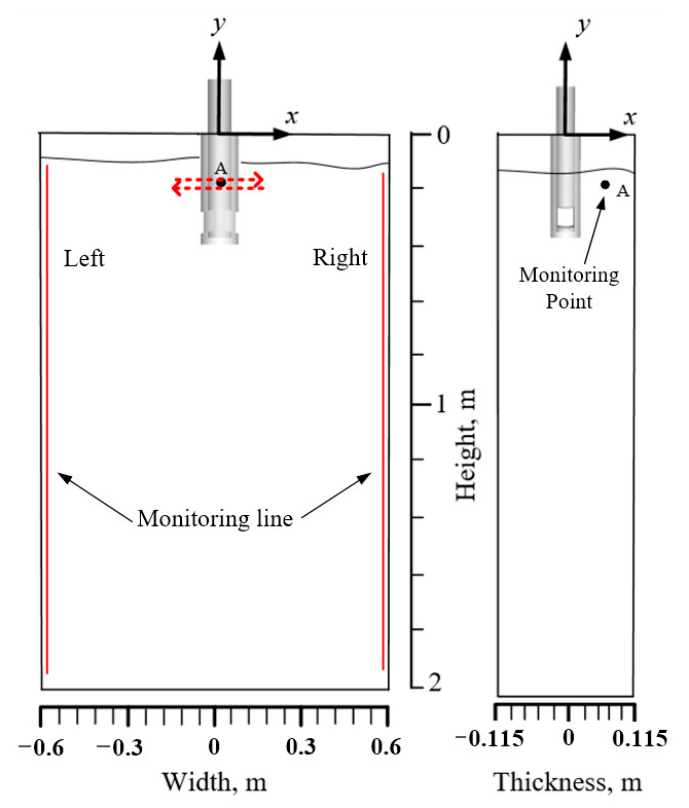
Figure 16. Schematic illustration of the crossflow and the monitoring point A through the gaps between the SEN wall and mold width.